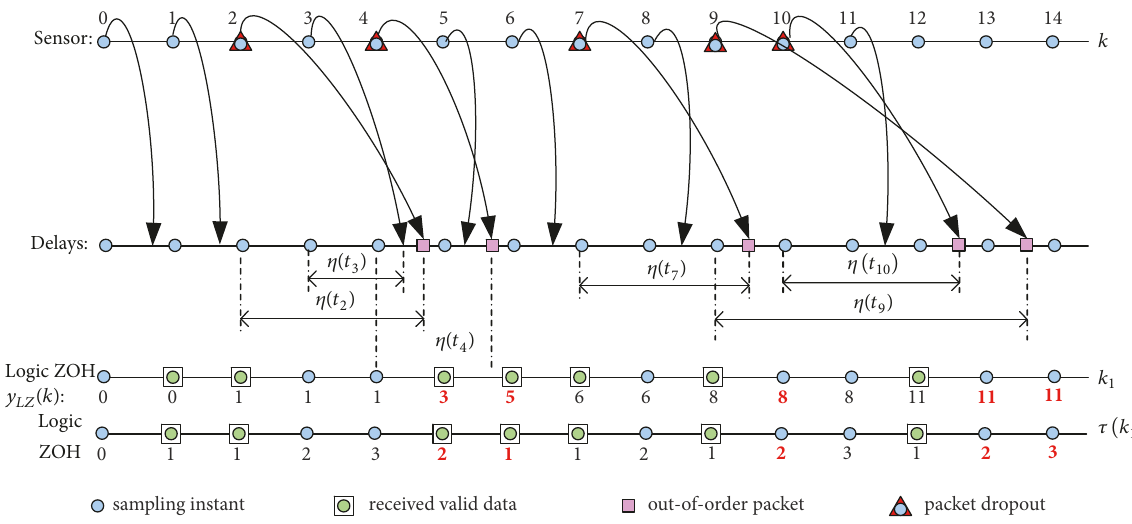
Figure 1: Sorting procedure for packet sequence based on event-triggered signal selection